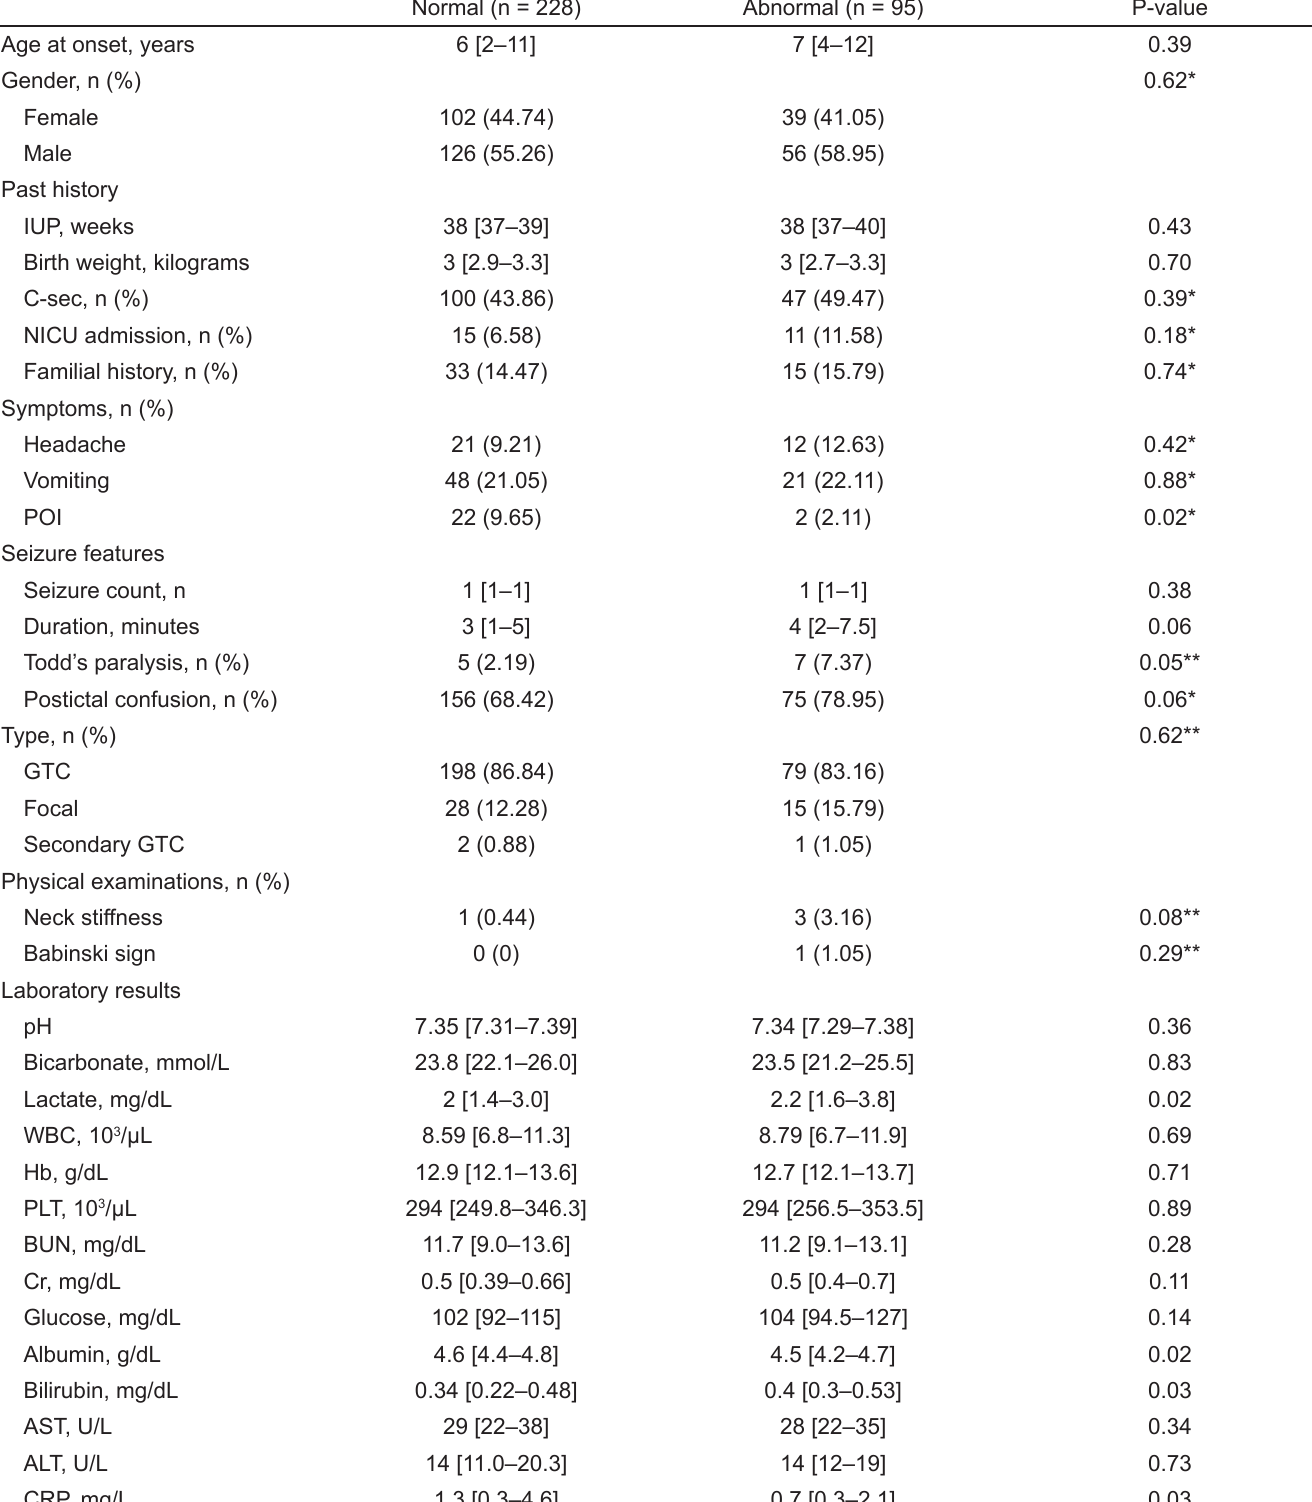
Table 2. Comparison of baseline characteristics between the two